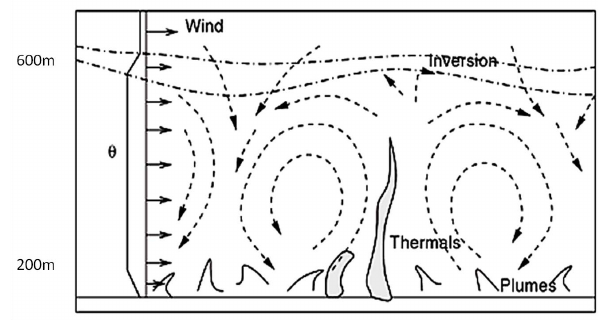
Fig. 14. Structure of the entrainment zone capping the convective atmospheric boundary layer. Horizontal scale is on the order of 10km. Adapted from Shao